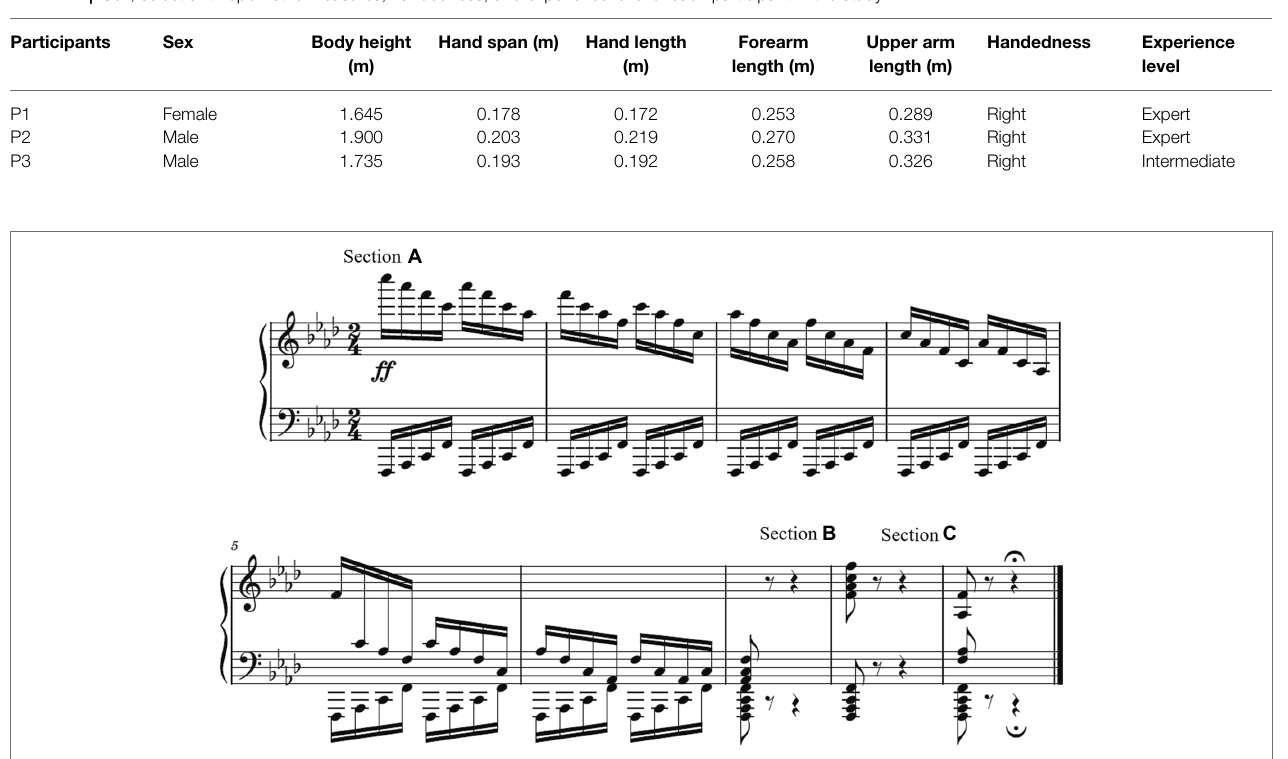
FIGURE 1 | The last 9 measures (mm. 363–371) from the 3rd movement of Beethoven’s Sonata in F Minor Op. 57 (“Appassionata”) with three identified motor behavior phases: gradual RH descent (Section A ), 2-octave medial-to-lateral RH jump (Section B ), and 1 octave lateral-to-medial RH jump (Section C